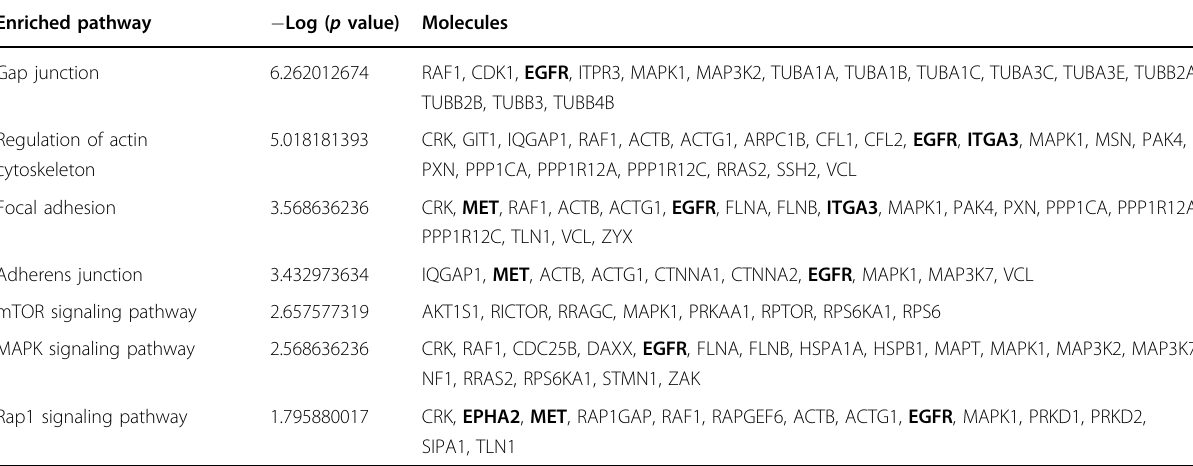
Membrane receptors are speci fi cally marked in